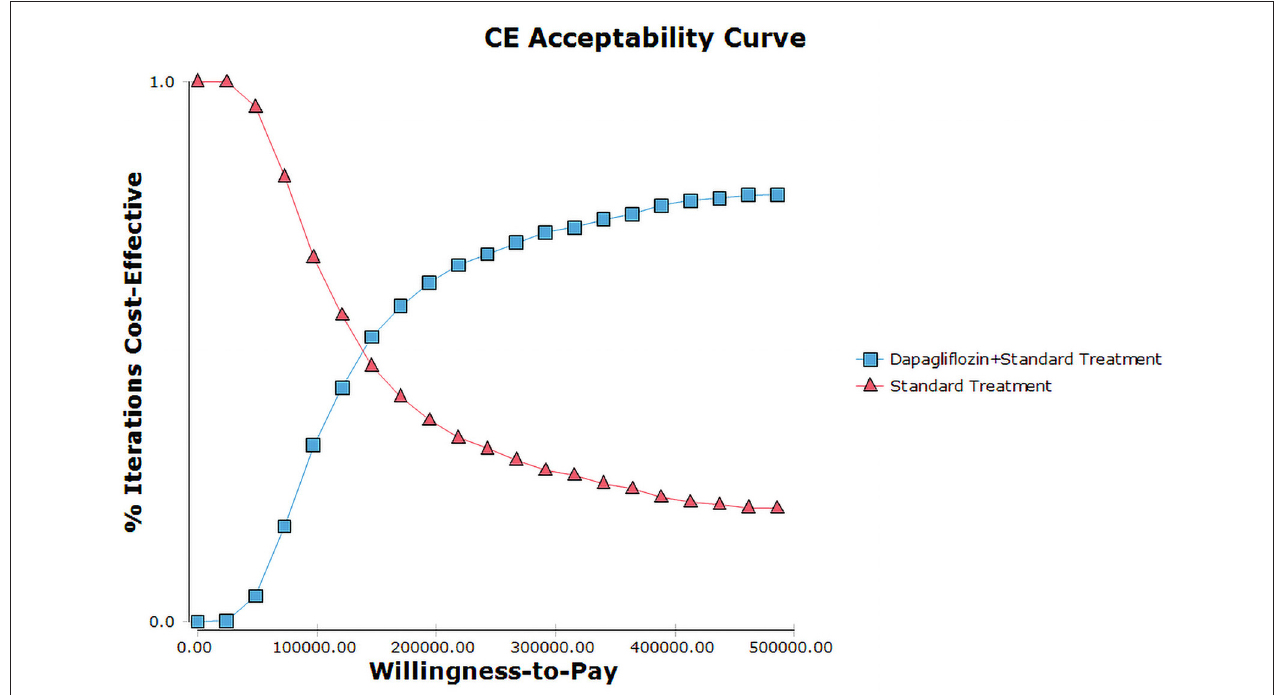
FIGURE 4 | Cost-effectiveness acceptability curves for dapagliflozin plus standard treatment vs. standard treatment.